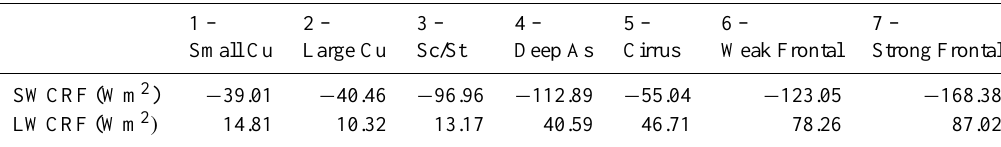
Fig. 1. Mean ISCCP histograms of cloud fraction for each cloud-top pressure and cloud optical thickness interval. Table 2. Grid box mean ISCCP cloud radiative forcing for each